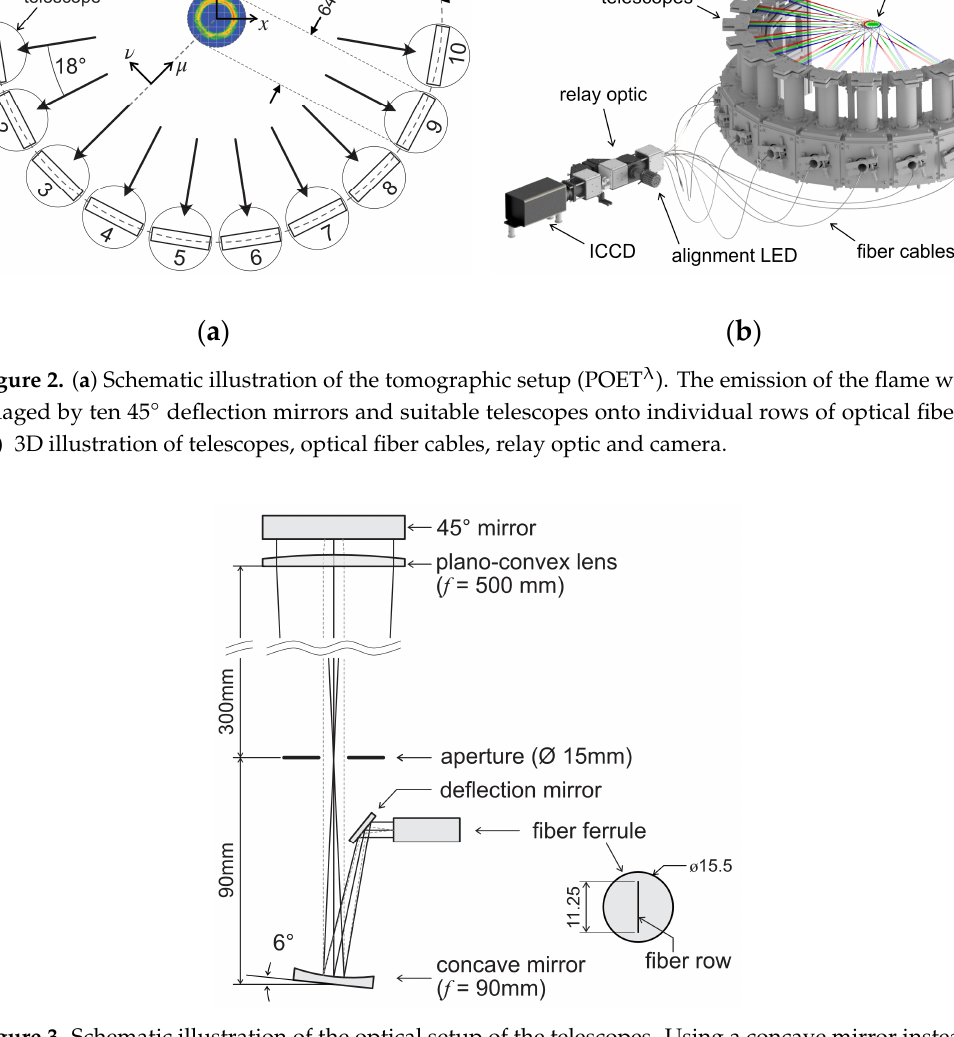
Figure 2. ( a ) Schematic illustration of the tomographic setup ( POET (cid:3090) ). The emission of the flame was imaged by ten 45° deflection mirrors and suitable telescopes onto individual rows of optical fibers. ( b ) 3D illustration of telescopes, optical fiber cables, relay optic and camera.